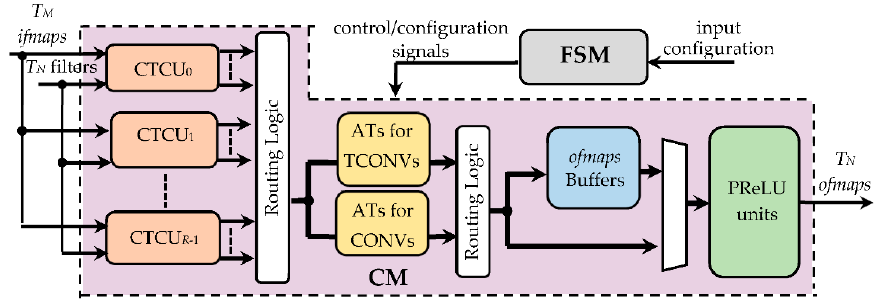
Figure 5. The top-level architecture of the proposed hardware accelerator.